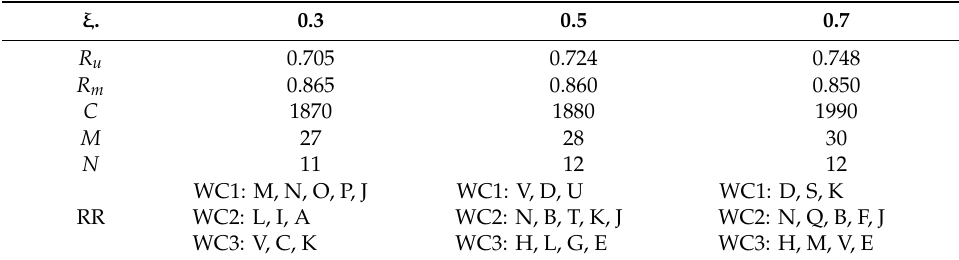
Table 6. Restoration results for di ff erent ξ .